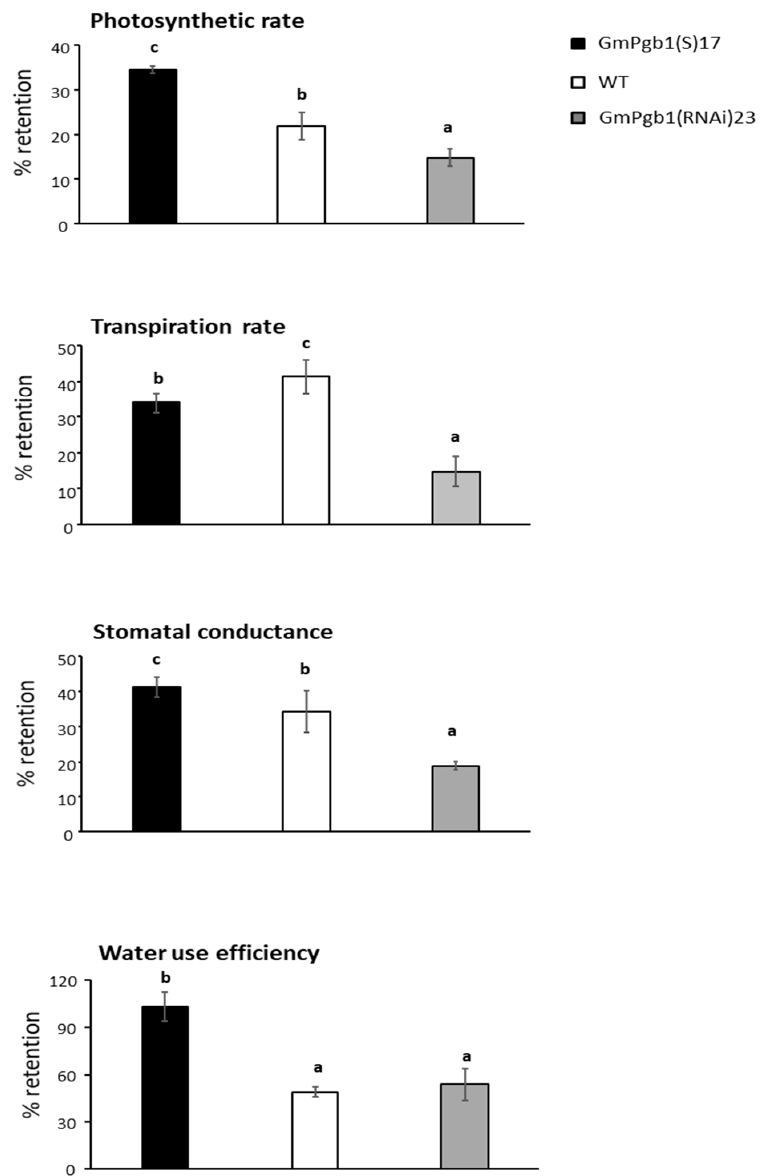
Figure 2. Retention, expressed as the percentage of control (Na 2 SO 4 ), of the photosynthetic rate, the transpiration rate, the stomatal conductance, and the water use efficiency of Na 2 SO 4 -treated soybean plants overexpressing (GmPgb1(S)17) or downregulating (GmPgb1(RNAi)23) GmPgb1 . Measurements were conducted after 24 h of treatment. Values are the means ± SE of at least three biological replicates each consisting of at least five plants. Letters indicate statistically significant differences ( p < 0.05).